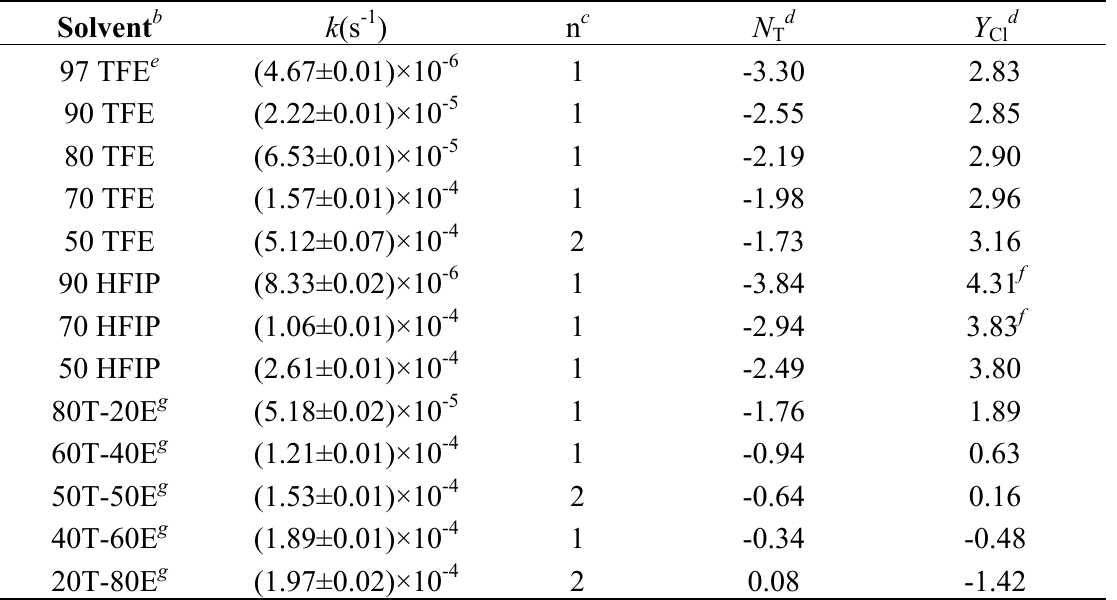
Table 4 . Specific rates of solvolysis ( k ) of trans - β -styrenesulfonyl chloride ( 3 ) a in binary mixtures of water with 2, 2, 2-trifluoroethanol (TFE) and 1, 1, 1, 3, 3, 3-hexafluoro-2- propanol (HFIP) and in TFE-ethanol (T-E) mixtures at 45.0